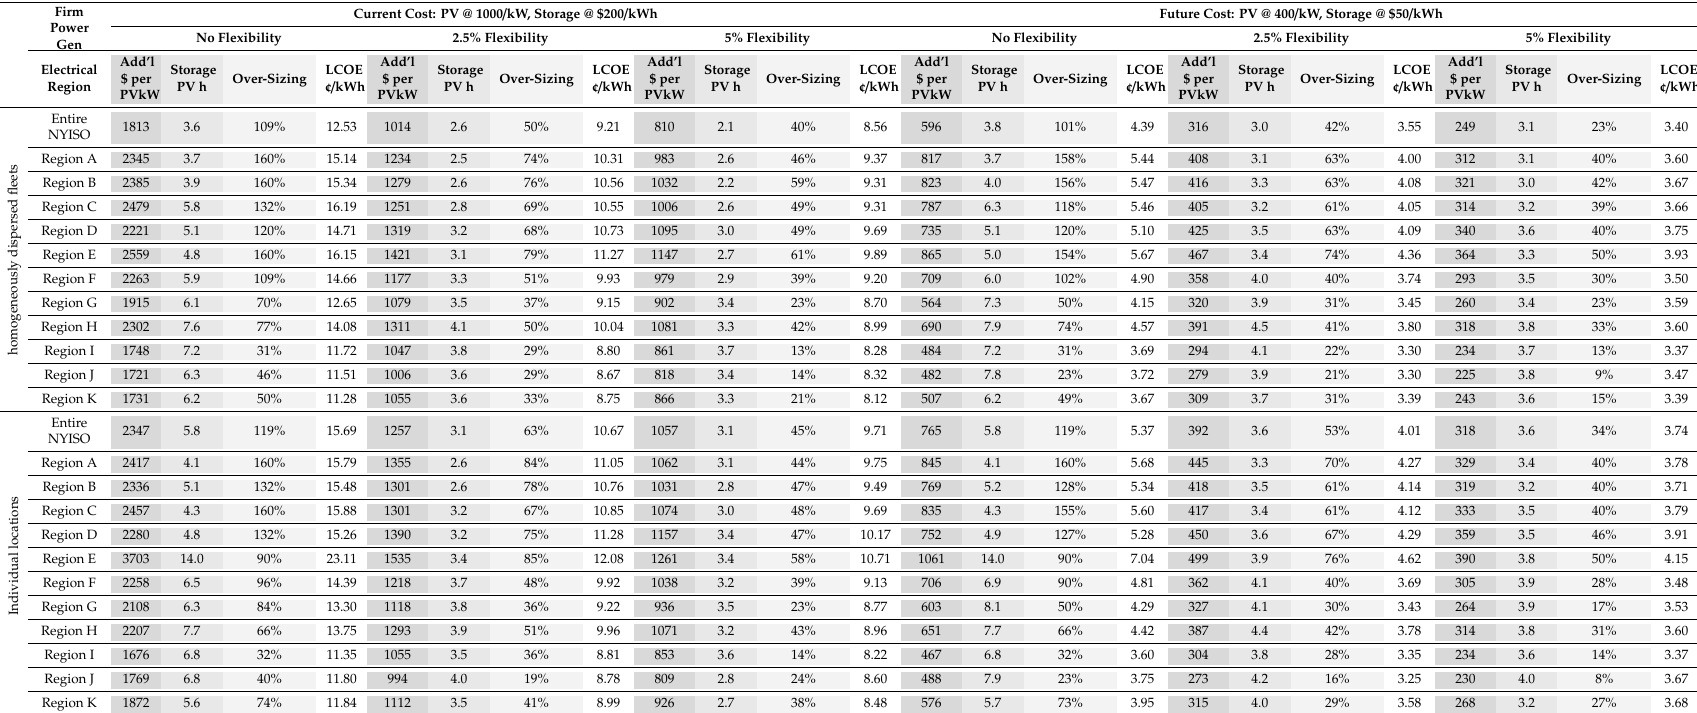
Table 7. Firm generation at 25%